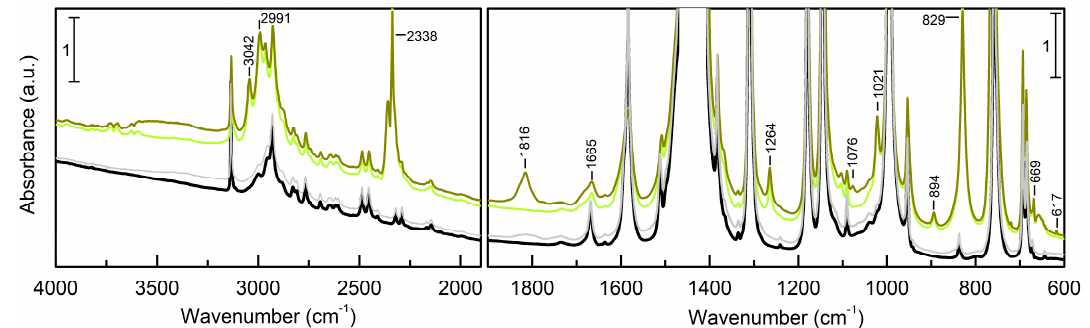
Figure 5. FTIR spectrum of ZIF-8 degassed at 300 °C ( black curve ). On this sample, a gas mixture of 150 mbar of PrO and 600 mbar of CO 2 was dosed at 35–40 °C ( light orange curve ) and left in contact with the sample at this temperature for 4 days ( orange curve ). After this time, the sample was degassed at 35–40 °C for 15 h: the corresponding spectrum is reported in the figure as a grey line.